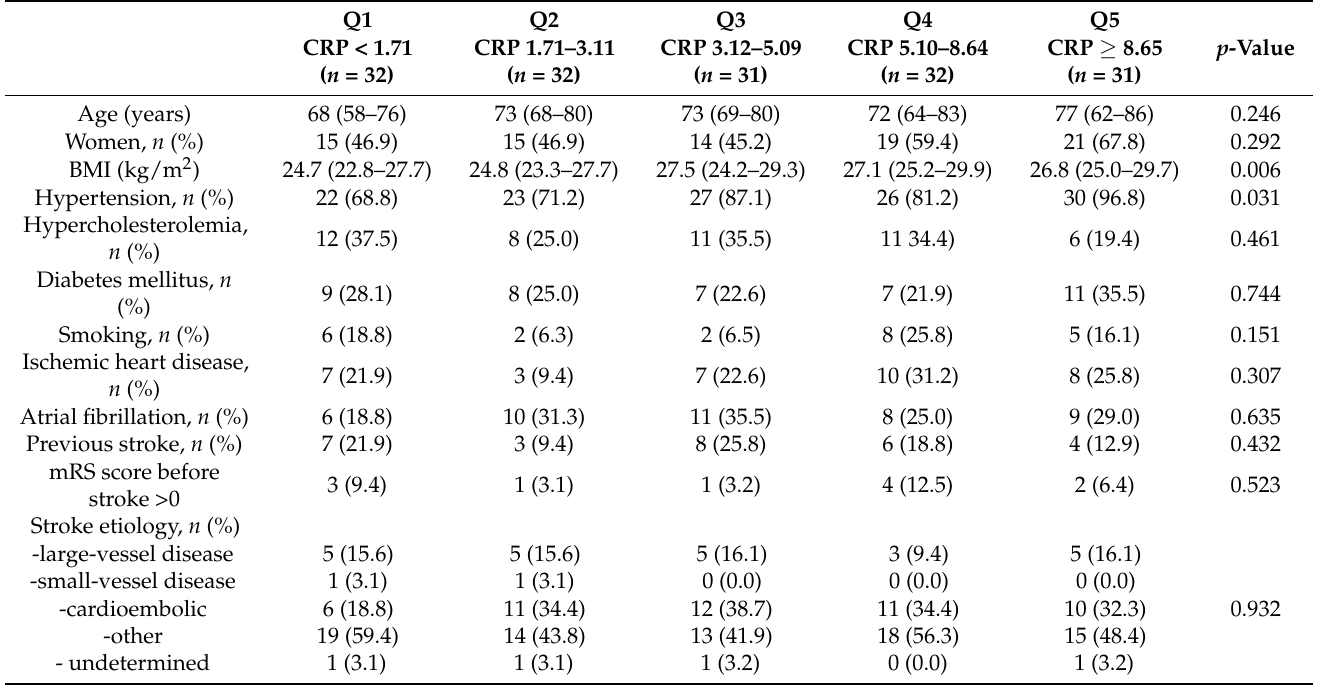
Table 1. Baseline clinical characteristics of the patients based on C-reactive protein (CRP)